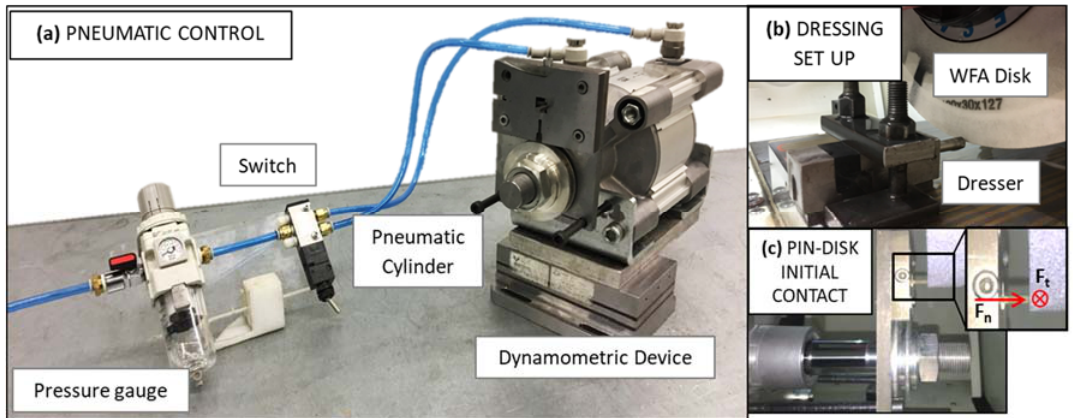
Figure 1. ( a ) Set up of pneumatic control of pin-on-disk, ( b ) dressing set up of vertical surface of the wheel and ( c ) initial contact between pin and disk on the vertical and conditioned wheel surface.